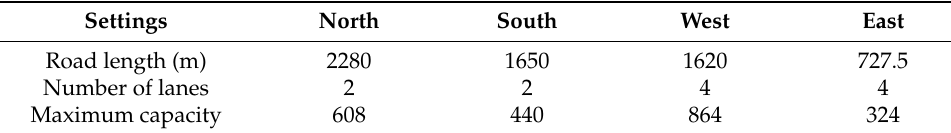
Table 2. Percentage of outgoing flow.